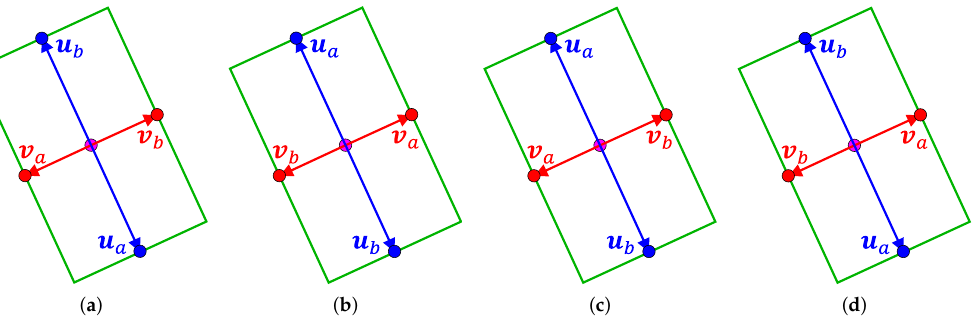
Figure 6. Illustration of the four potential shape descriptor representations for an OBB according to different key point assignment rules. ( a ) assigns u b and v a to the left, ( b ) assigns u a and v b to the left, ( c ) assigns both u a and v a to the left, ( d ) assigns both u b and v b to the